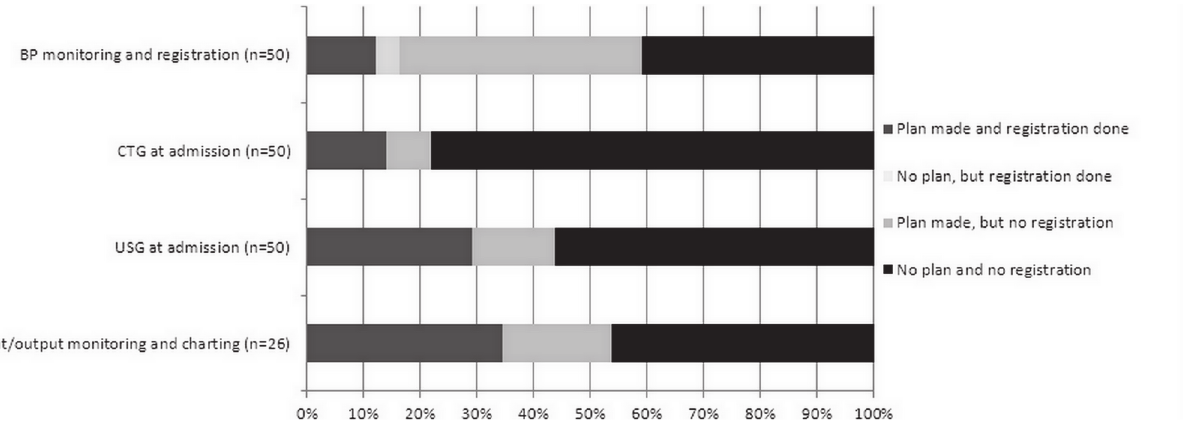
Fig 2. Level of adherence to four specific criteria of the protocol of severe pre-eclampsia (n = 50), Ridge Regional Hospital, Accra, Ghana,